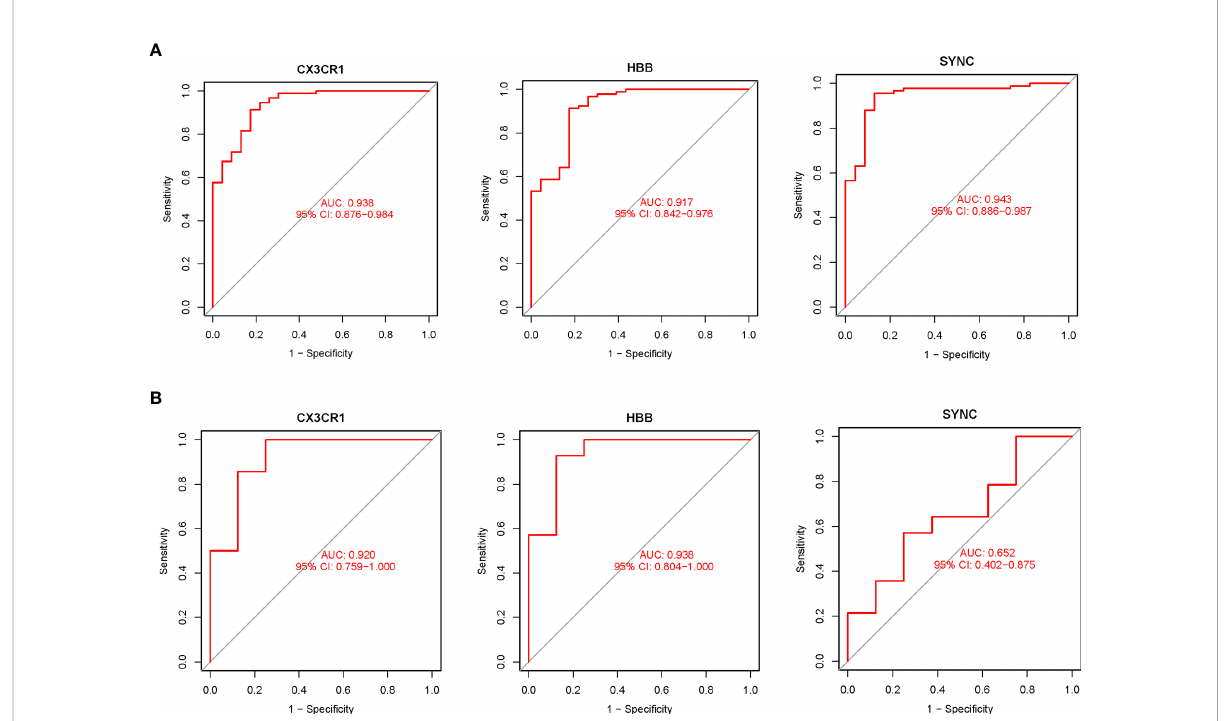
FIGURE 5 The diagnostic accuracy of the 3 potential biomarkers was assessed using ROC curve analysis. (A) Diagnostic ability of potential biomarkers in the training datasets. The AUC represents the diagnostic ability in Treat and Con groups. (B) Diagnostic accuracy of potential biomarkers in the validation datasets. The AUC represents the diagnostic accuracy in Treat and Con